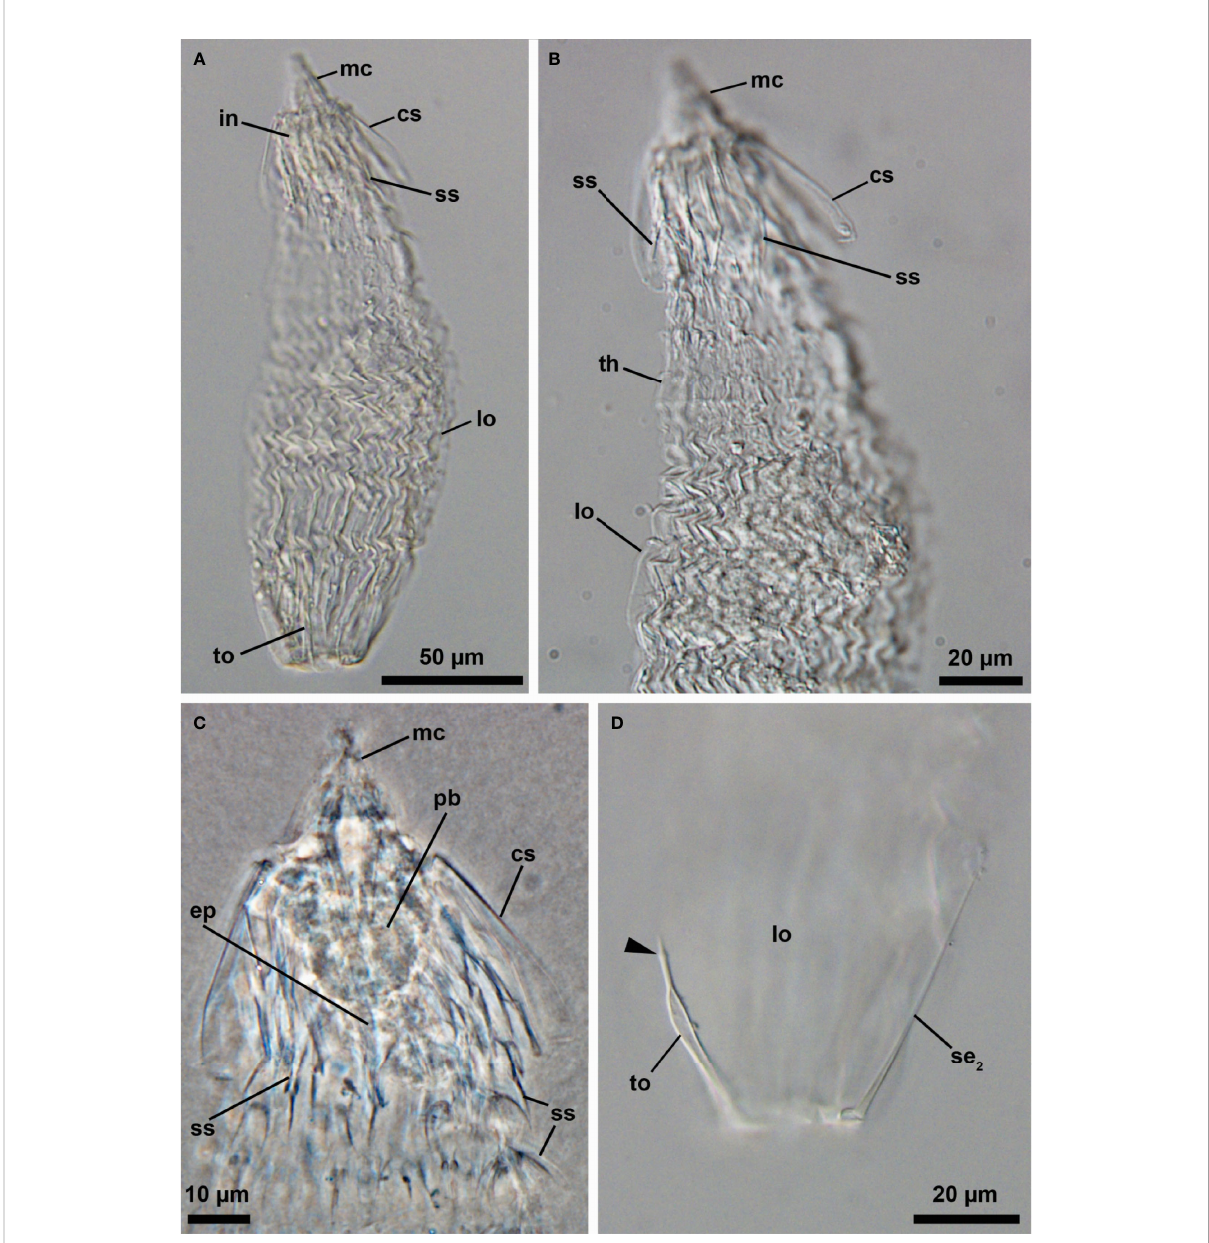
FIGURE 3 Light micrographs of the Higgins larva of an undescribed genus (NHMD-621043). (A) Overview. Ventral view, anterior faces up. (B) Posterior region of the body. (C) Close-up of the anterior region of the body. (D) Posterior region of the body. Note the small bulge near the distal end of the toe (arrowhead). Abbreviations: cs, clavoscalids; in, introvert; lo, lorica; mc, mouth cone; pb, pharyngeal bulb; se 2 , posterolateral seta; ss, spinoscalid; th, thorax; to,